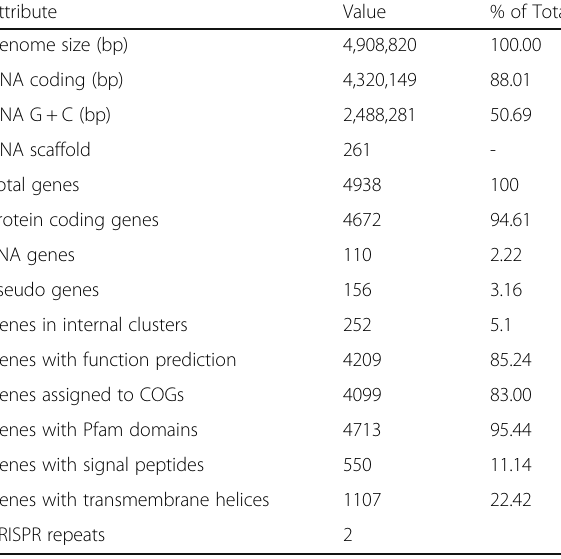
Table 4 Genome statistics